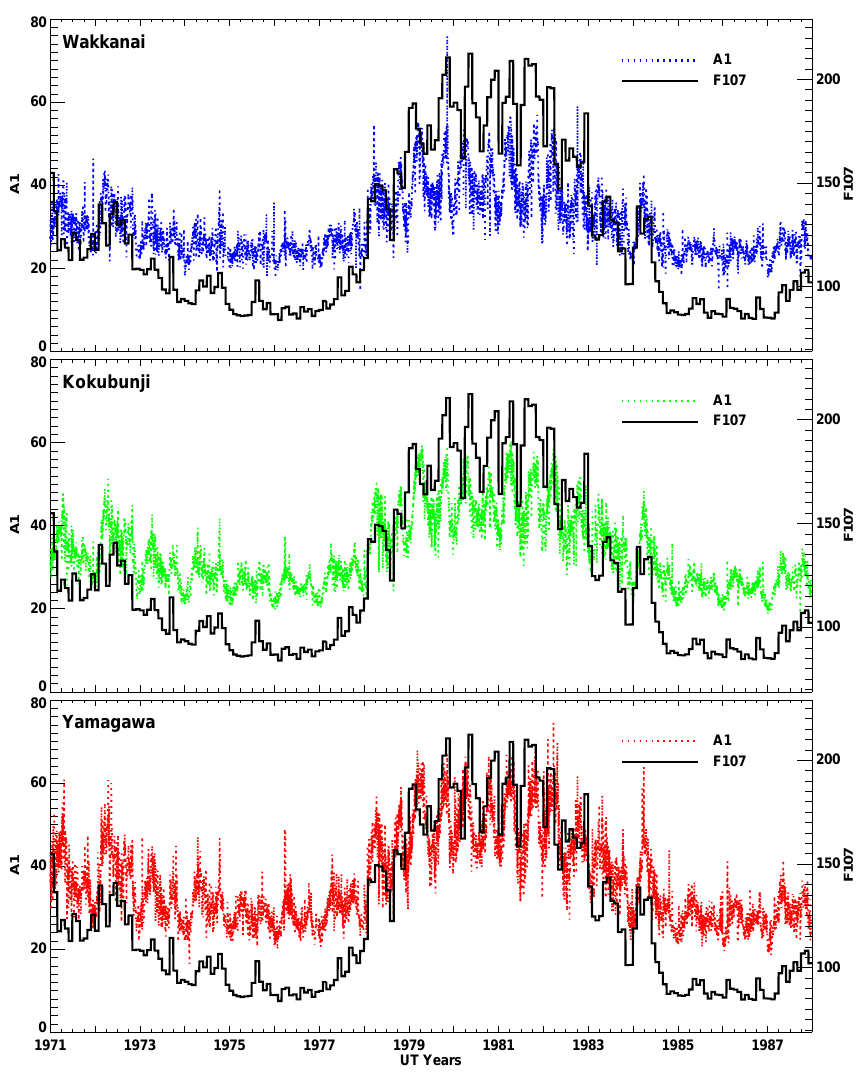
Fig. 3. Long-term variation of F 10 . 7 and the 1st EOF coefficients from